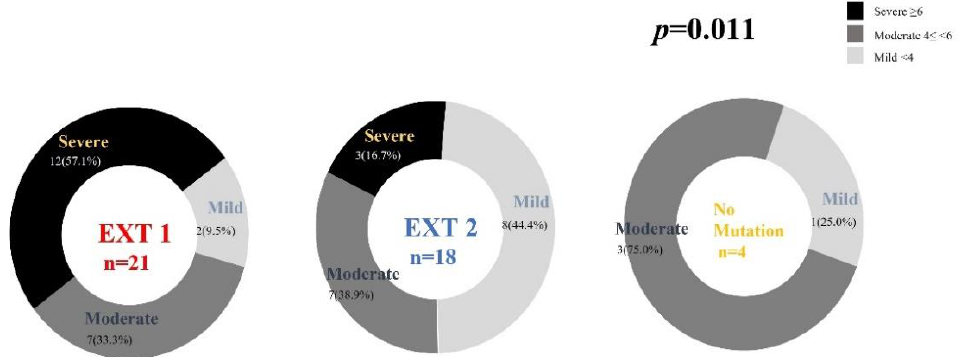
Figure 4. Phenotype – genotype correlations in patient with multiple hereditary exostoses according Figure 4. Phenotype–genotype correlations in patient with multiple hereditary exostoses according to the type of gene mutation. to the type of gene